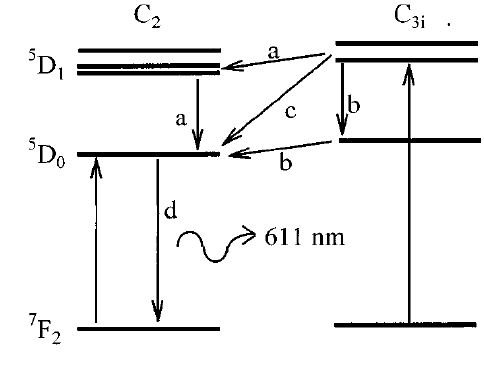
O :Eu at symmetry sites C 2 3